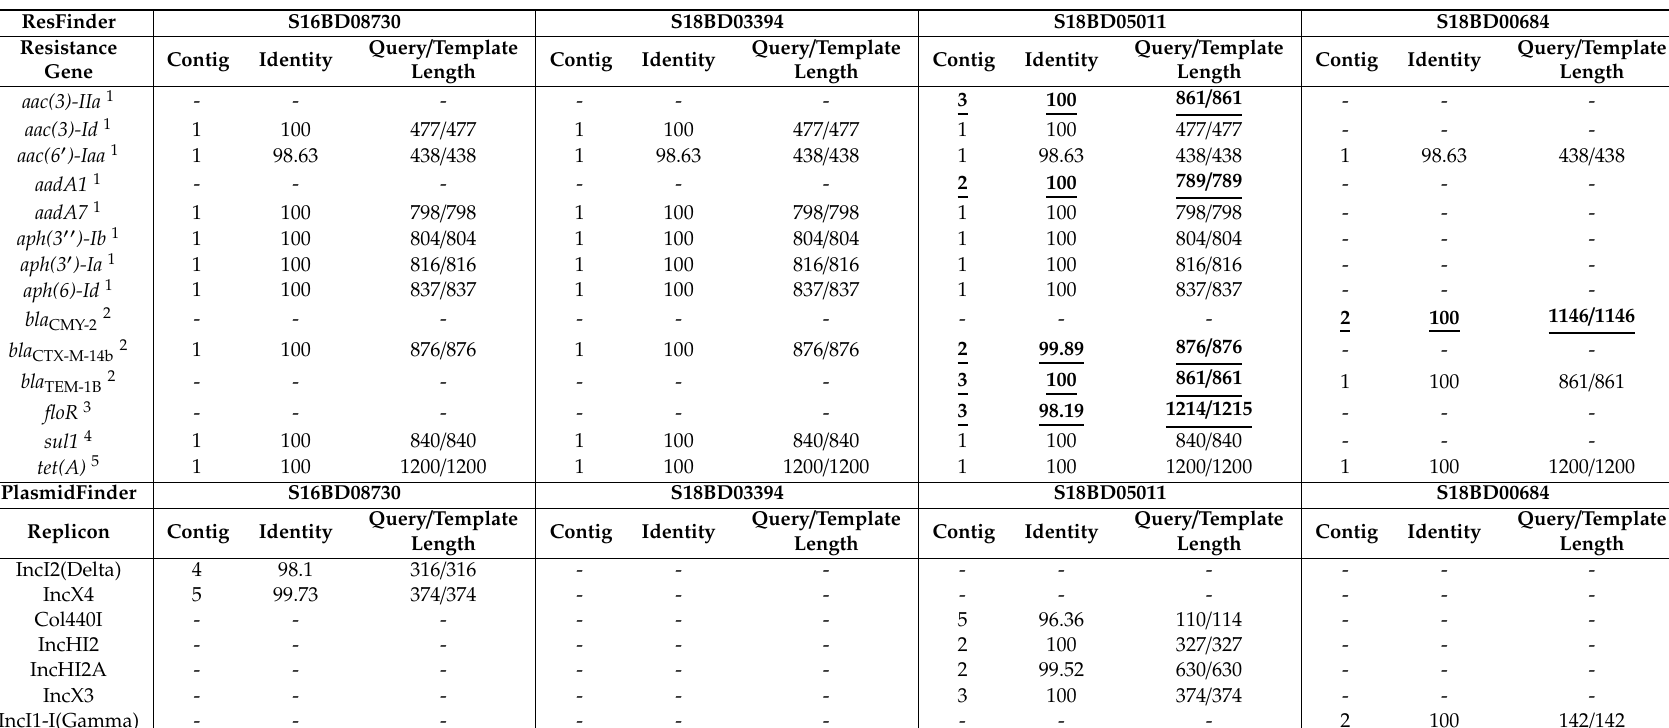
Table 6. ResFinder and PlasmidFinder output of the Salmonella Kentucky isolates S16BD08730, S18BD00684, S18BD03994 and